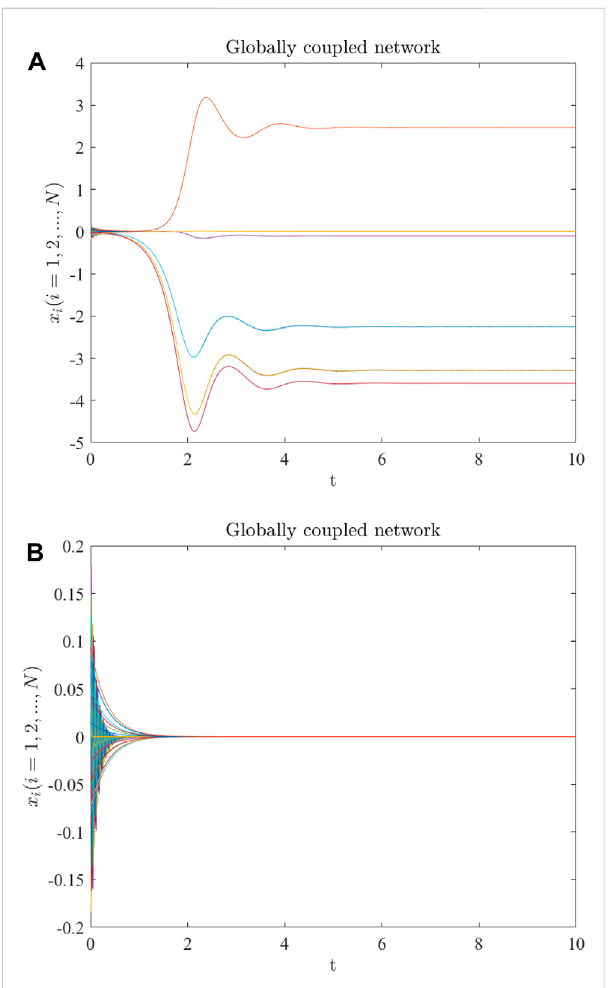
FIGURE 6 Evolution of the node states in a 200-node